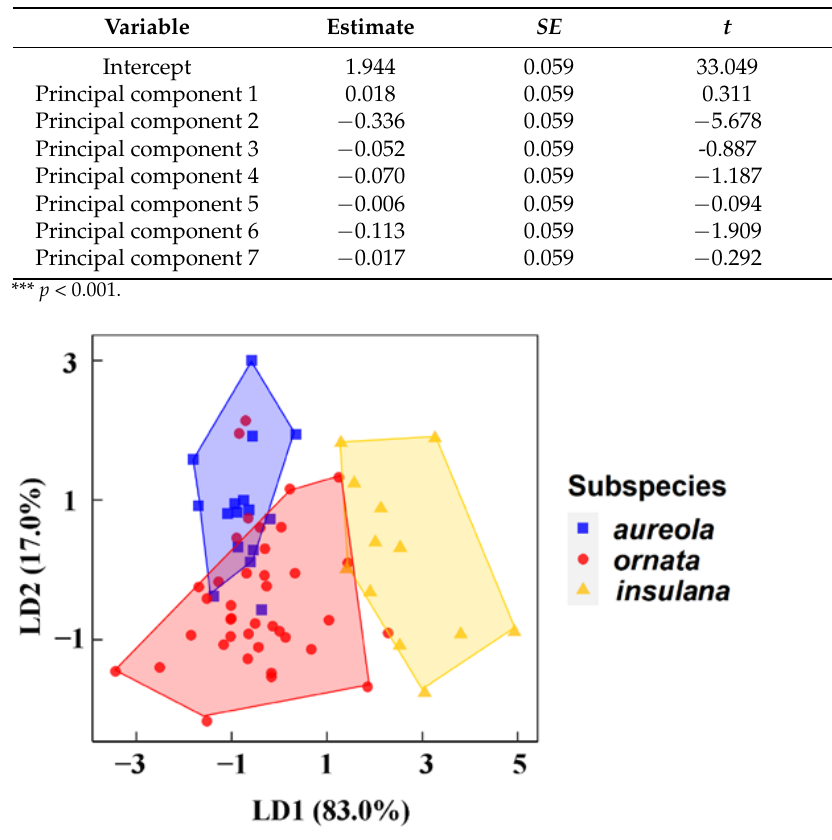
Figure 3. Linear discriminant analysis (LDA) indicated that the three subspecies could be separated completely by the first two discriminant functions.